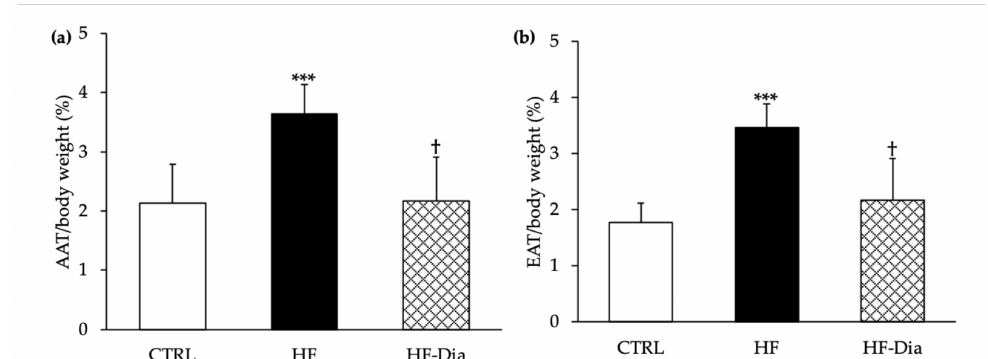
Figure 2. Effects of D. lutheri supplementation on abdominal adipose tissue ( a ) and epididymal adipose tissue ( b ) weight. AAT, abdominal adipose tissue; CTRL, control group; EAT, epididymal adipose tissue; HF, high-fat group; HF-Dia, high-fat group supplemented with D. lutheri . Values are means ( n = 6), with standard deviations represented by vertical bars. Statistical significance was determined using ANOVA with post hoc Fisher’s test and mean values were significantly different from those of the CTRL group with *** p < 0.001. † Significant difference compared with the HF group ( p <